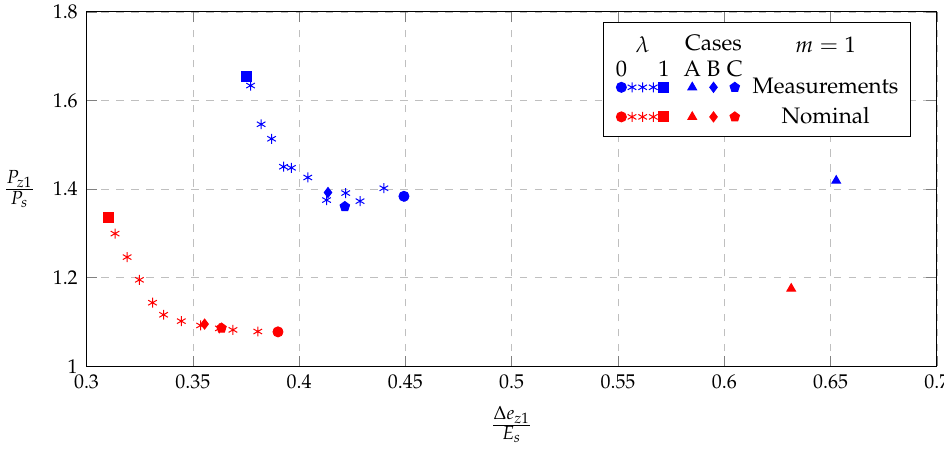
Figure 8. Measurement results and nominal values of the Pareto frontier and the cases A, B, and C for a low-voltage MMC with R z = 166.9m Ω , V Tz = 4.522V, ˆ I = 10A, φ = 0° and m =